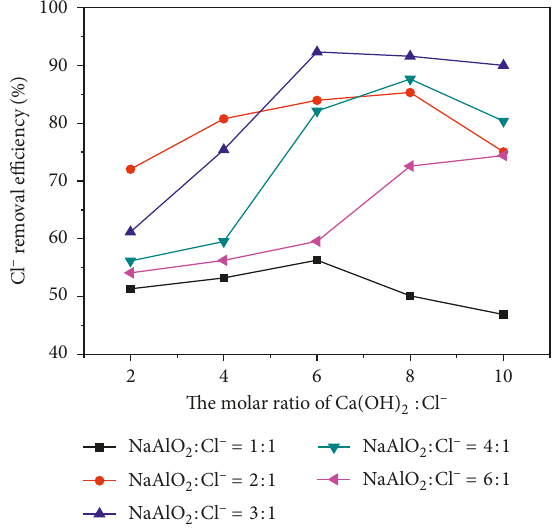
Figure 2: The effect of Ca(OH)